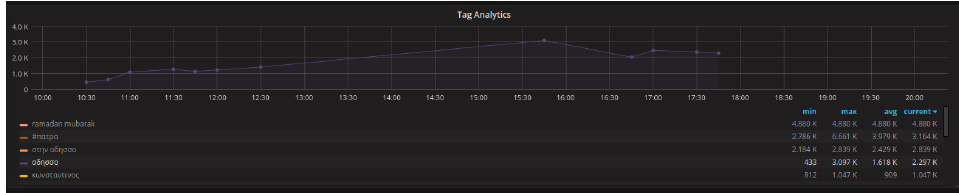
Figure 3. Single term evolution in time.